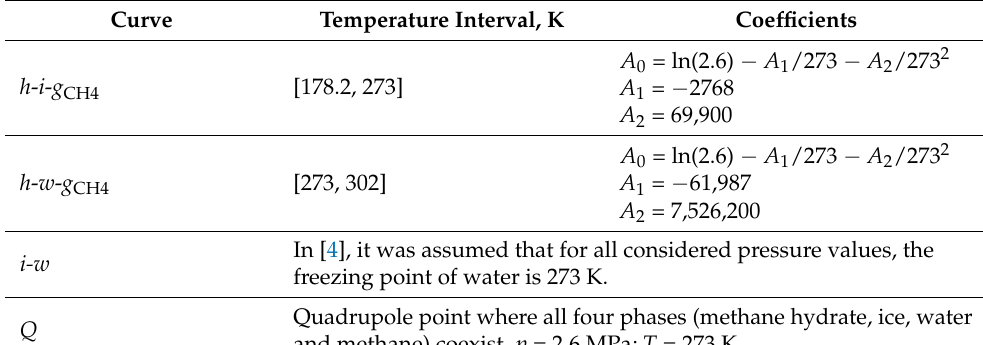
Table 4. Coefficients for the phase equilibrium curves of methane hydrate, Equation (11) [4].